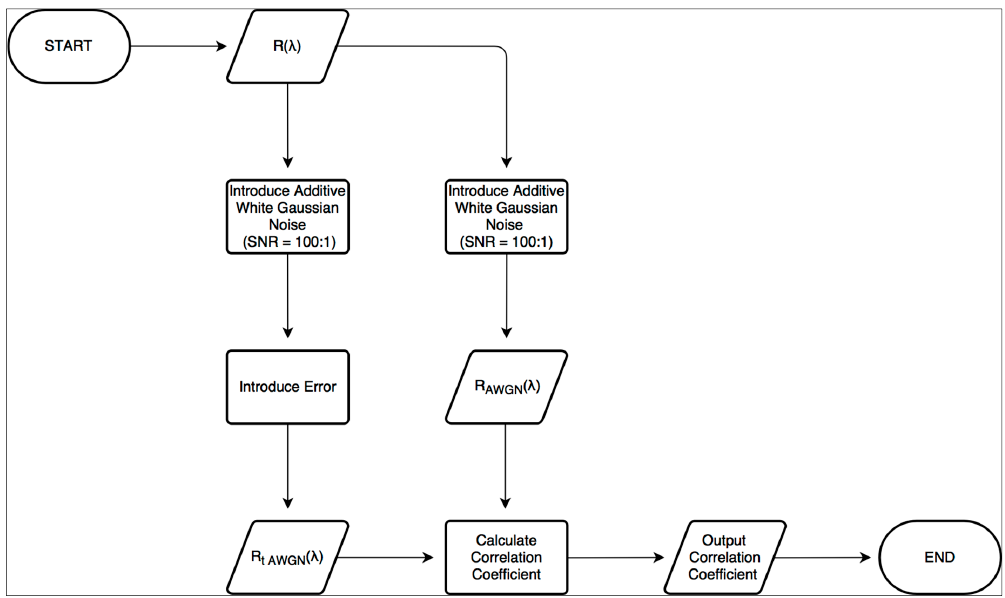
Figure 4. Schematic view of the basic algorithm for the characterization of the CC in the presence of signal noise.